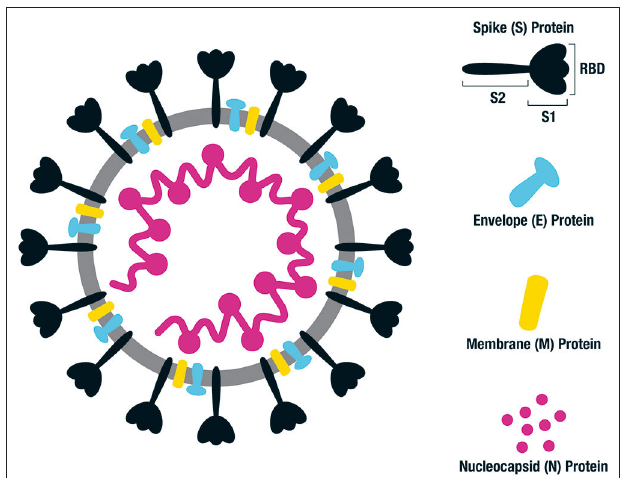
FIGURE 1 | Structure of SARS-CoV-2 and key antigenic components. Illustration of SARS-CoV-2 which is a single stranded RNA virus. The key antigenic components being targeted in vaccine design are shown on the right, consisting of the spike (S), envelope (E), membrane (M), and nucleocapsid (N) proteins. The main emphasis for human vaccines is based on the spike (S) protein, consisting of an S1 binding region and S2 fusion and cell entry region. The S1 domain contains the receptor binding domain (RBD) responsible for binding to the ACE2 receptor on the surface of host cells. Following fusion, the S protein sheds the S1 region and undergoes a dramatic structural change to its post-fusional state in order for the virus to enter the host cells.